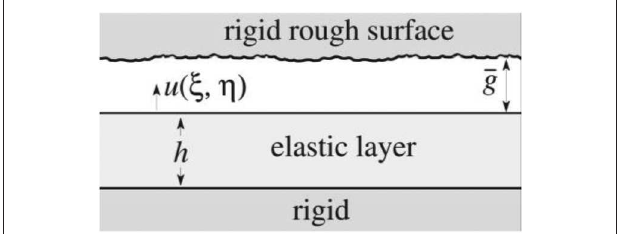
FIGURE 1 | A rigid body with a plane surface that may contain some surface roughness is placed near to an elastic layer bonded to a rigid foundation. The g and u ( ξ , η ) is the local elastic displacement of the layer mean gap is ¯